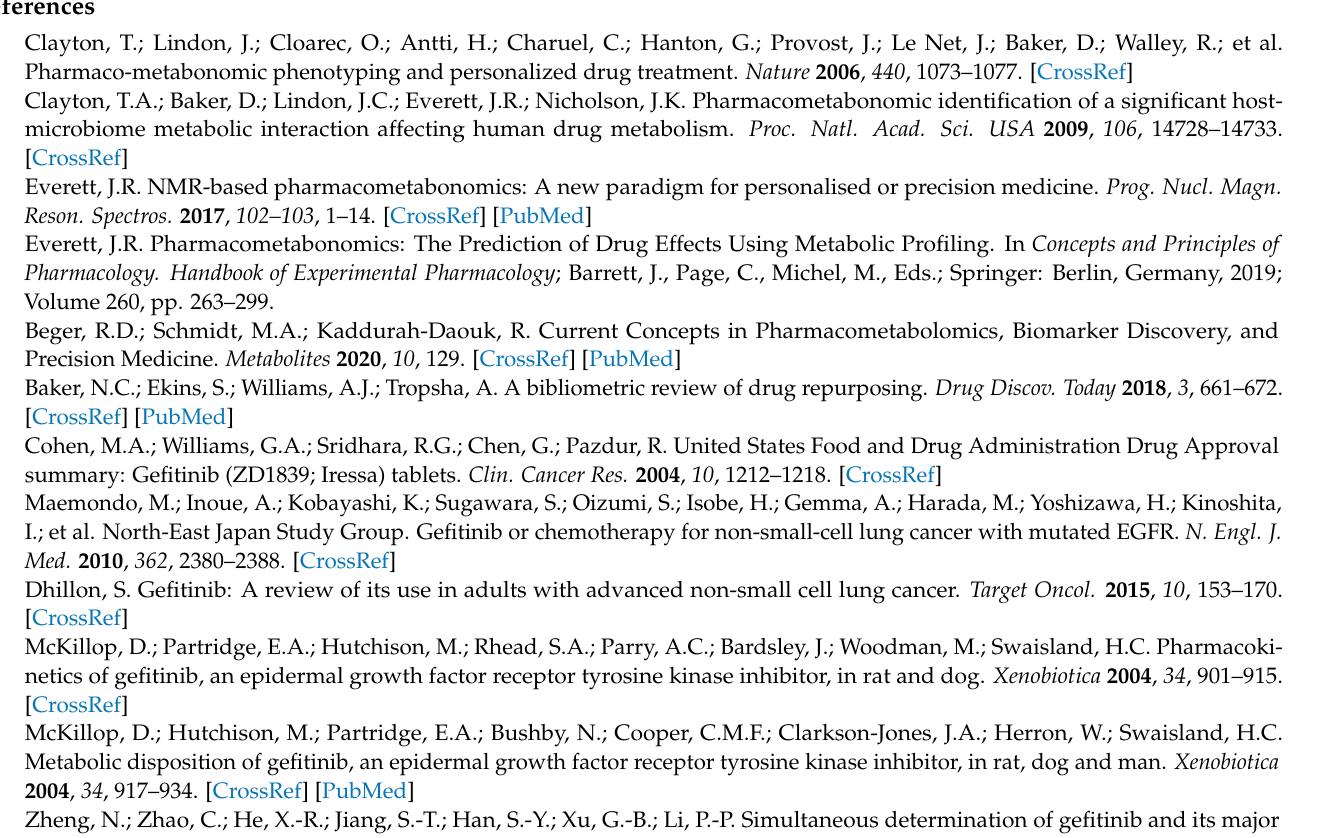
of negative ESI data. Figure S3: PCA of both positive and negative ESI data for control animals. Figure S4: Heatmaps representing control and IV groups. Figure S5: Tryptophan fragmentation, positive ESI. Figure S6: Tryptophan acetonitrile adduct, positive ESI. Figure S7: Taurocholic acid fragmentation, negative ESI. Figure S8: Arginyl-lysine, positive ESI. Figure S9: Arginyl-lysine, negative ESI. Figure S10: Deoxyguanosine, positive ESI. Figure S11: Deoxyguanosine, acetonitrile adduct, positive ESI. Figure S12: 8-Hydroxy-deoxyguanosine, positive ESI. Figure S13: Asparaginyl- histidine, positive ESI. Table S1: Positive ion data for pooled QC data. Table S2: Negative ion data for pooled QC